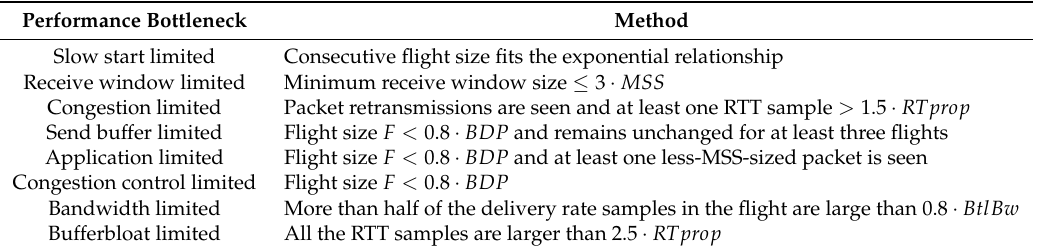
Table 1. Summary of EVA’s method to identify performance